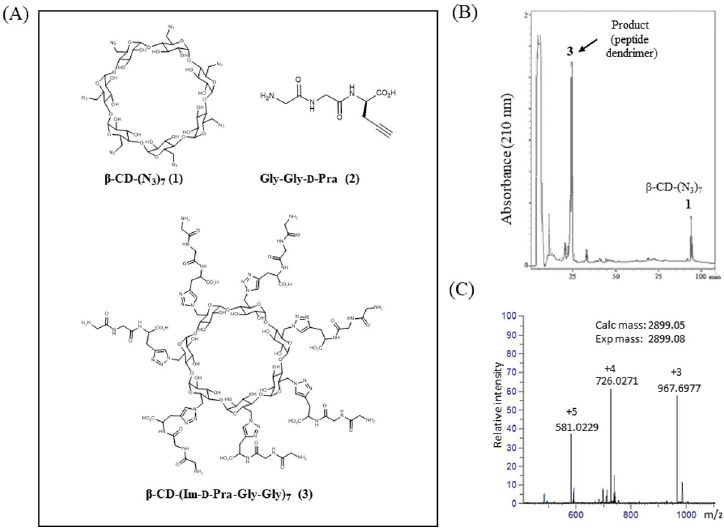
Fig 2. (A) Chemical structures used in the study: per-6-deoxy-6-azido- β -cyclodextrin ( 1 , β -CD(N 3 ) 7 ), Gly-Gly-D-Pra ( 2 ) and click ligation product 3 , β -CD-(Im-D-Pra-Gly-Gly) 7 ] of 1 and 2 . (B) RP-HPLC profile of the click reaction between 1 and 2 , (C) ESI-MS of the product peak ( 3 ). The calculated m/z value is indicated in